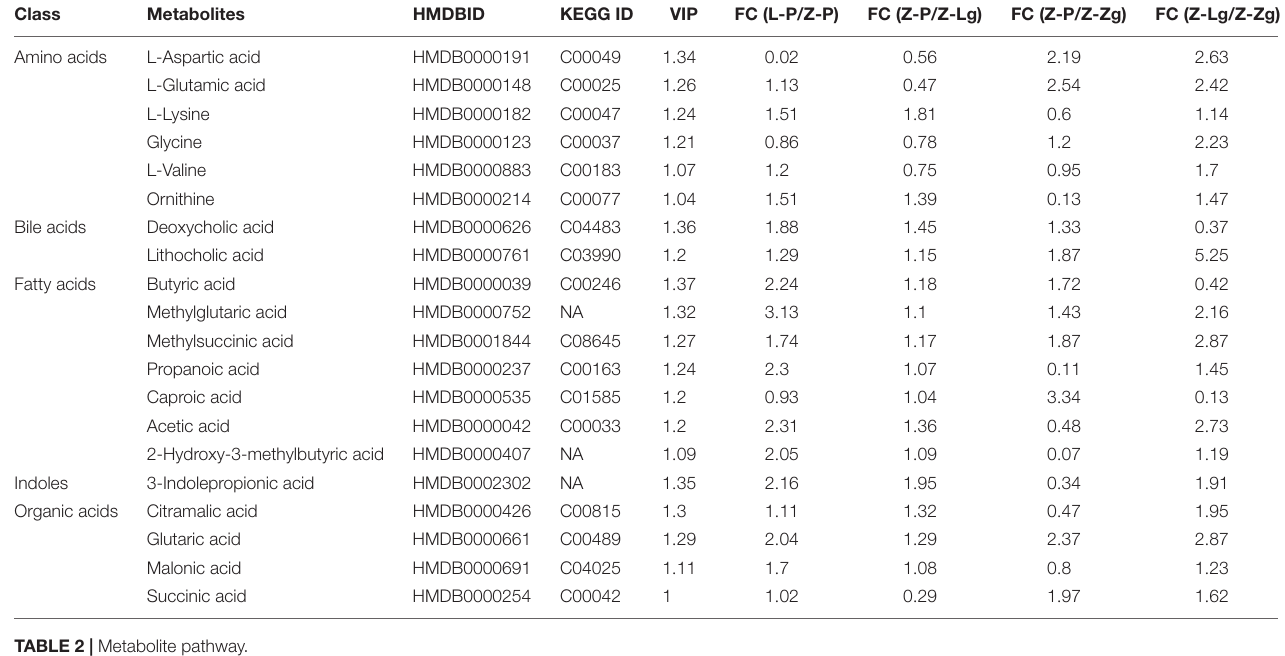
TABLE 1 | Potential differential metabolites.